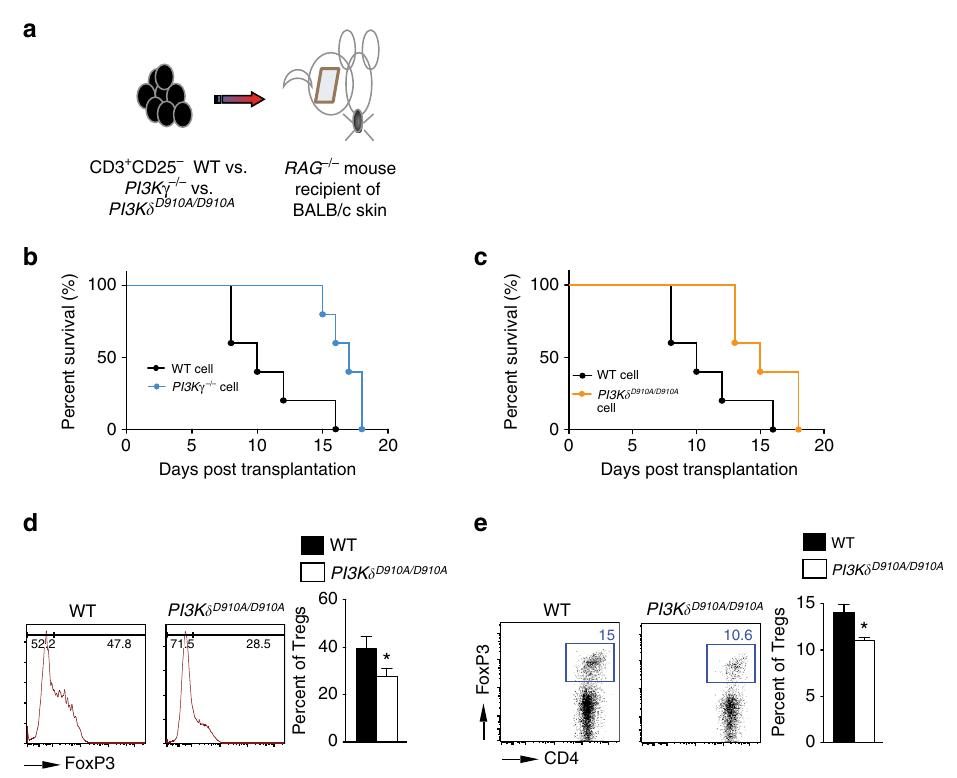
Fig. 1 PI3K γ or PI3K δ deletion impairs T cell activation in vivo. a Schematics describing the methodology used in this experiment. RAG − / − mice received a BALB/c skin allograft; on day 1 post-transplant, the mice were injected with 6 × 10 6 CD3 + CD25 − T cells isolated from splenocytes of PI3K γ − / − , PI3K δ D910A/D910A or WT naive mice. b Graft survival in recipients of PI3K γ − / − T cells signi fi cantly exceeded that in recipients of control T cells (MST of 17 vs. 10 days, respectively, * p < 0.05, t -test, n = 5/group). c Graft survival in recipients of PI3K δ D910A/D910A T cells signi fi cantly exceeded that in recipients of control T cells (MST of 15 vs. 10 days, respectively, * p < 0.05, t -test, n = 5/group). d Representative fi gures of fl ow cytometry analysis of splenocytes retrieved from transplanted mice at day 7 post-transplant. Data shows signi fi cant decrease in Treg induction in the DLN of PI3K δ D910A/D910A recipients of BALB/c skin and WT controls (* p < 0.05, t -test, n = 3/group). Bar graph represents the percentage of Tregs. e Representative example of FACS staining of CD4 + PI3K δ D910A/D910A and WT T cells stimulated with anti-CD3/CD28 Abs in the presence of IL-2 and TGF β . (Data are representative of three separate experiments, * p < 0.05, t -test, n = 3 – 4/group). Bar graph represents the percentage of induced Tregs. d , e The graphs show data as mean ±